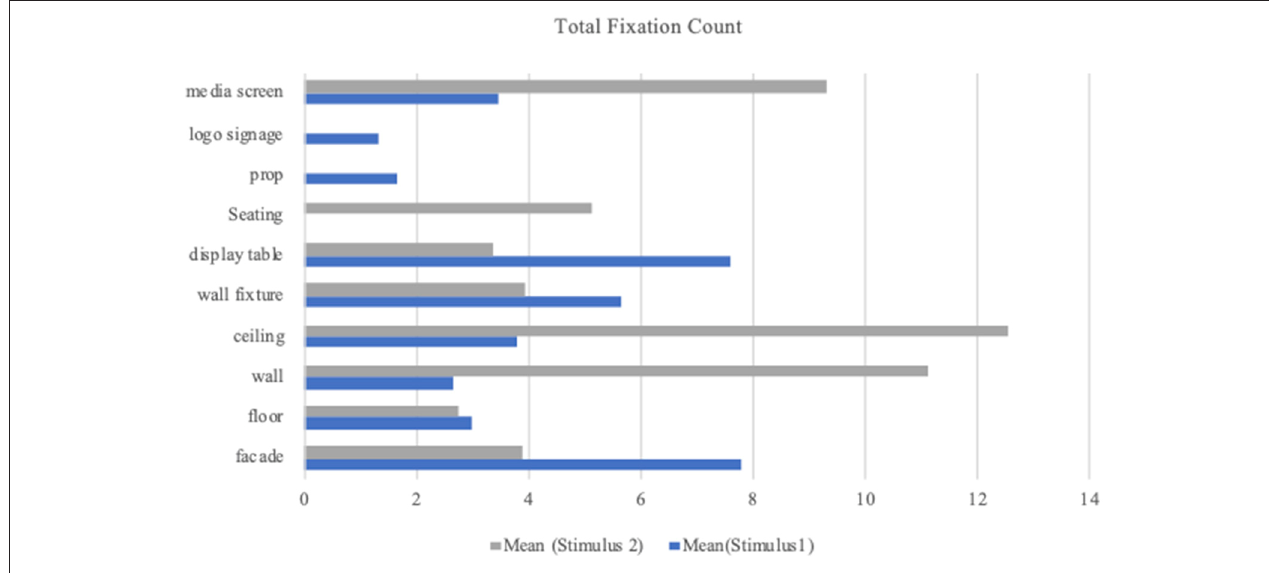
FIGURE 7 | Mean value of total fixation count per